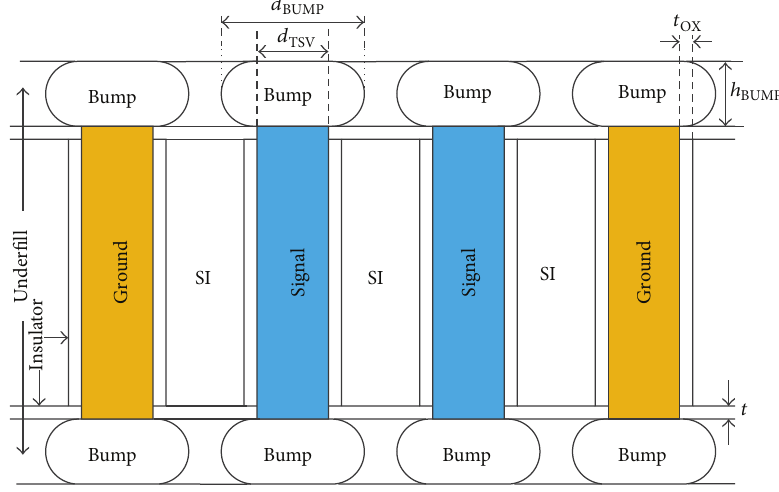
Figure 2: Proposed TSV model.